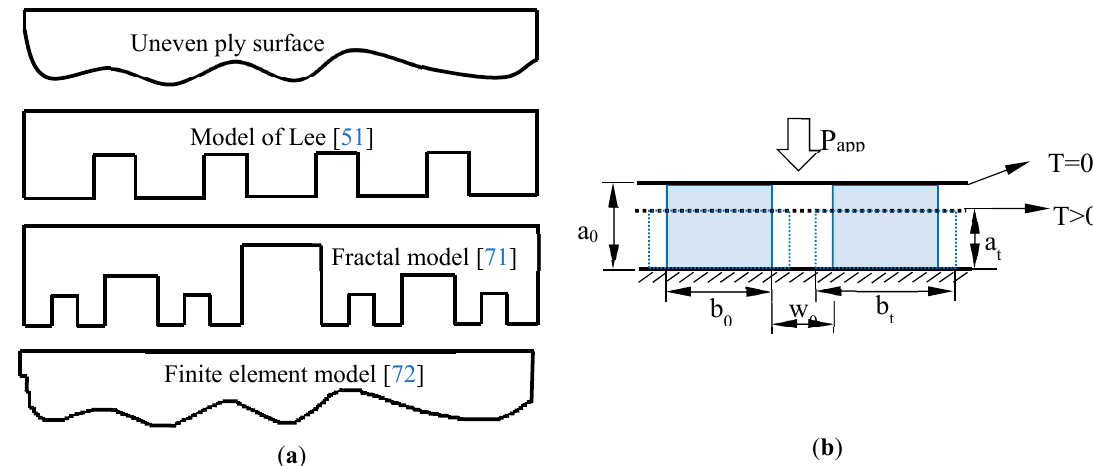
Figure 4. Intimate contact model: ( a ) Different approaches; ( b ) Discretization by regular rectangular elements.